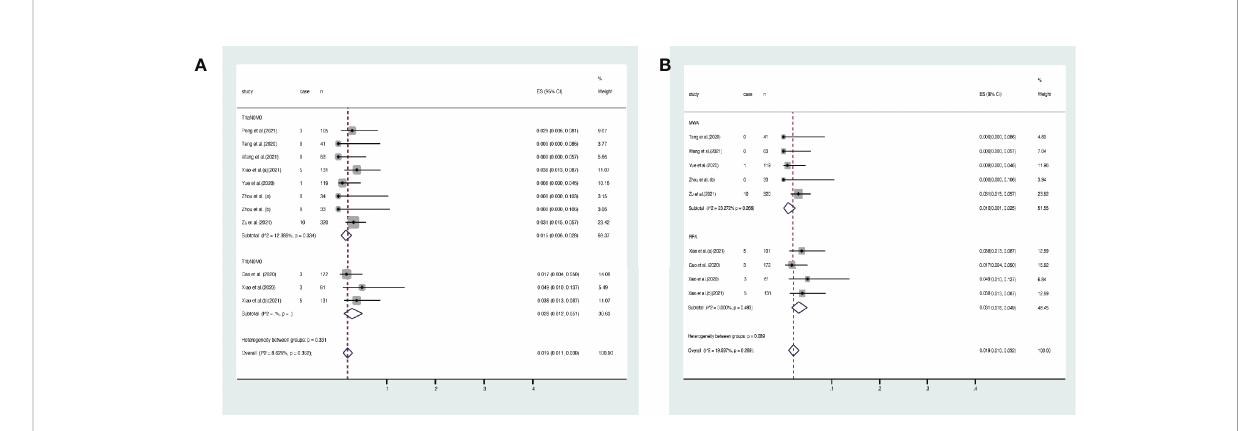
FIGURE 4 Forest plot of the overall disease progress rate after thermal ablations: (A) T1aN0M0 and T1bN0M0 studies, (B) MWA and RFA